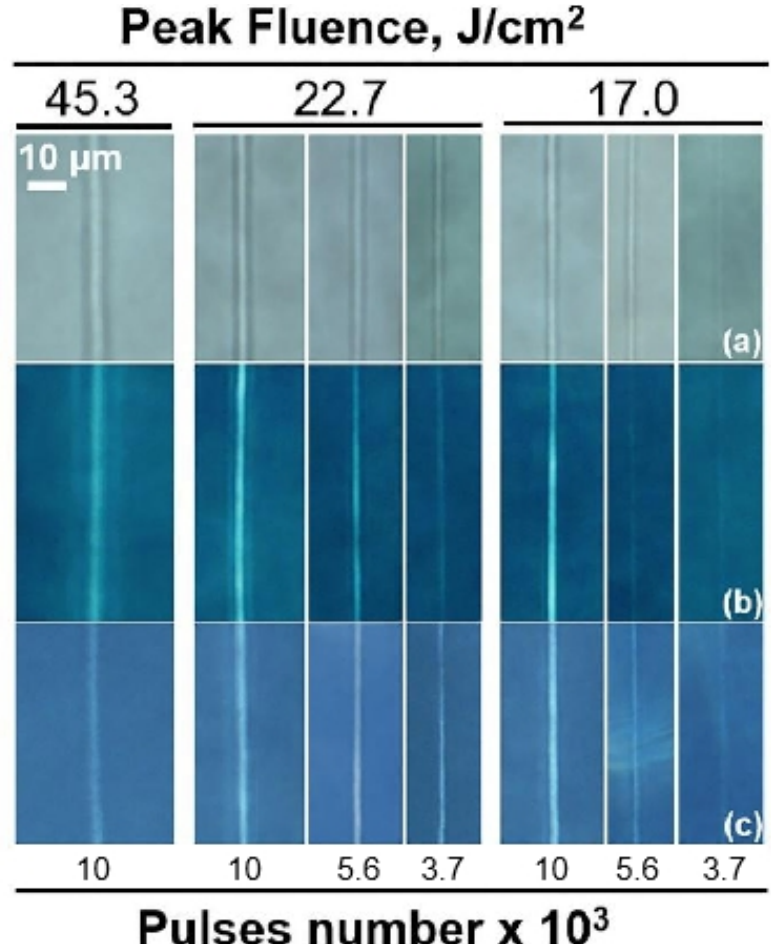
Figure 3. Images of waveguides in transmission light of microscopy ( a ). Polarized microscopy photos of waveguides in top view before ( b ) and after ( c ) heat treatment in a furnace (T = 500 °C, 2 h). The waveguides were fabricated at the peak fluence and number of laser pulses per region, which are indicated in the figure.